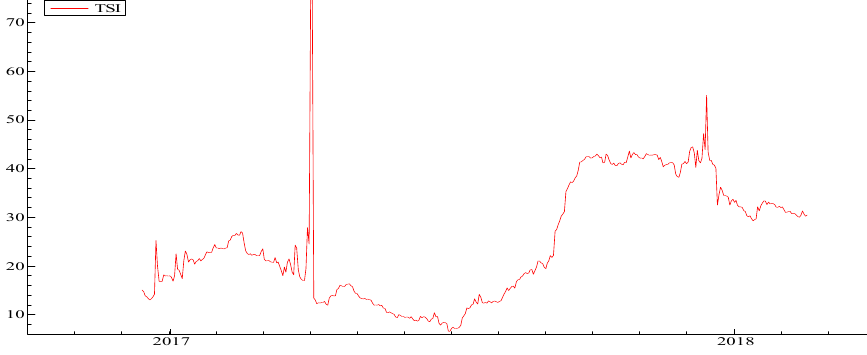
Figure 1. Dynamic of cryptocurrency spill over indexes: 100-days rolling window.